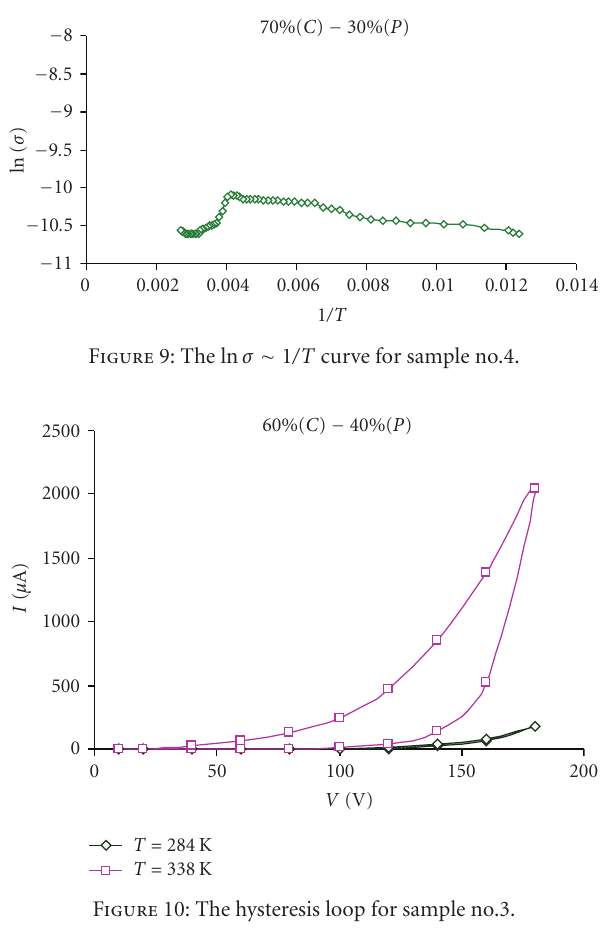
(v) ZnO based varistor with 0.00% polyaniline.